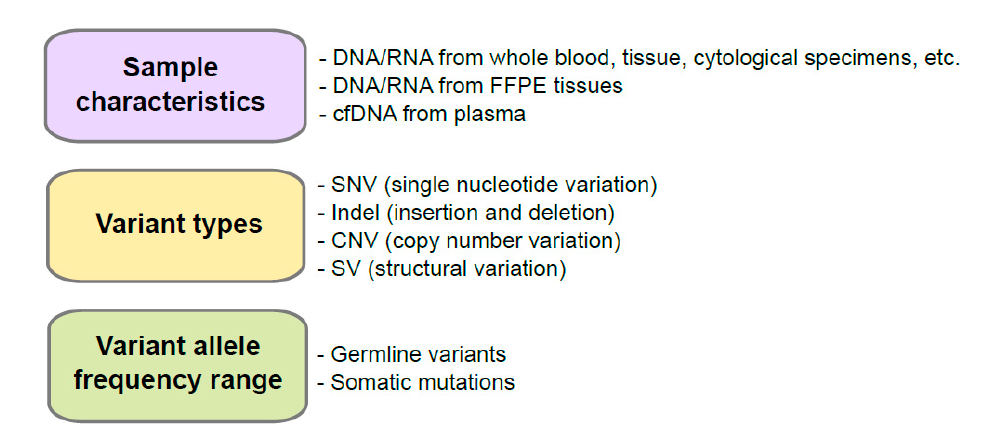
Figure 1. Consideration before development of control materials. FFPE, formalin-fixed and paraffin-embedded; cfDNA, cell-free DNA.